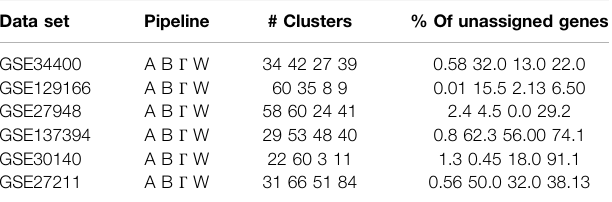
TABLE 1 | A Clustering summary. The number of modules and percentages of unassigned genes for the four pipelines Alpha (A), Beta (B), Gamma ( Γ ), WGCNA (W).